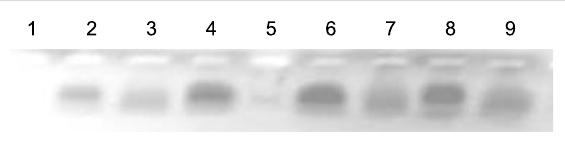
Figure 4: Results of electrophoresis in 2% TBE-agarose gel with ethidium bromide of RT-qPCR products from Figure 3. (Cleavage of total RNA from 10% brain suspensions from ICR mice infected with TBEV). Lanes: 1 - negative control; 2 and 3 - compound 5e incubated with RNA in RPMI 1640 and in H 2 O, respectively; 4 and 5 - compound 5g incubated with RNA in RPMI 1640 and in H 2 O, respectively; 6